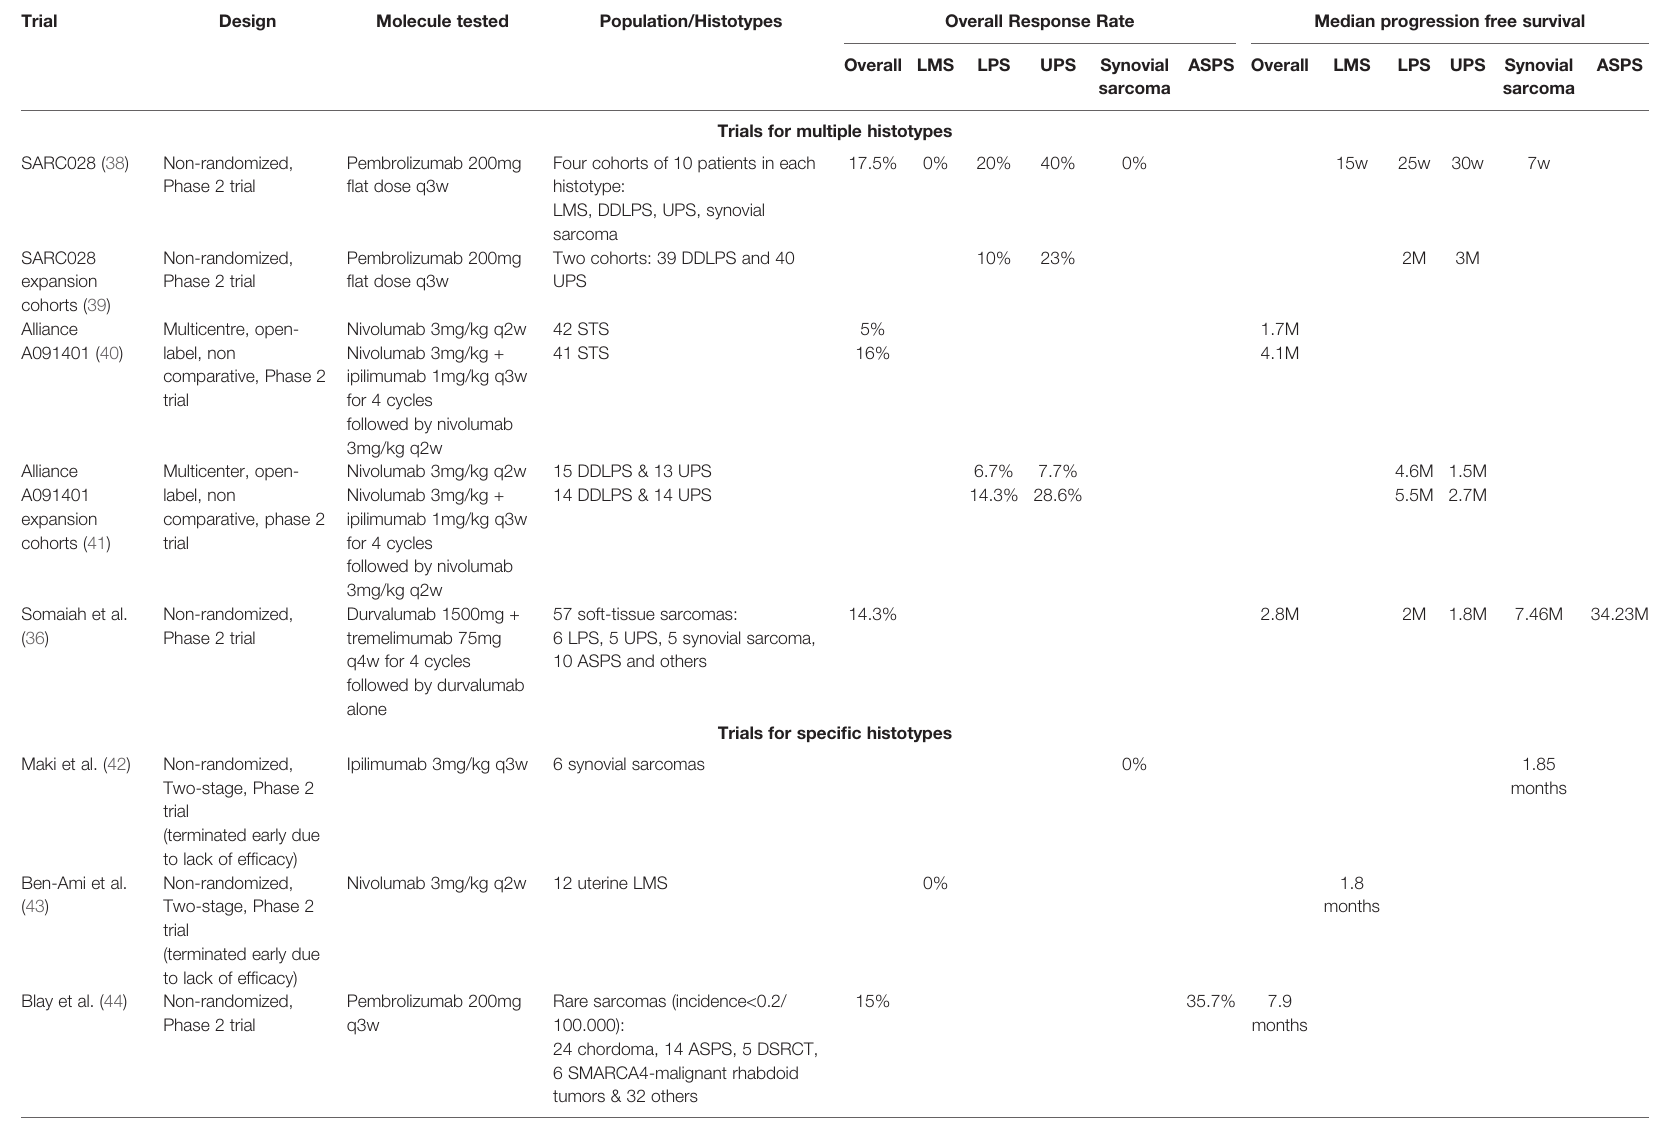
TABLE 1 | Trials of Immune Checkpoint inhibitors in advanced Soft-tissue